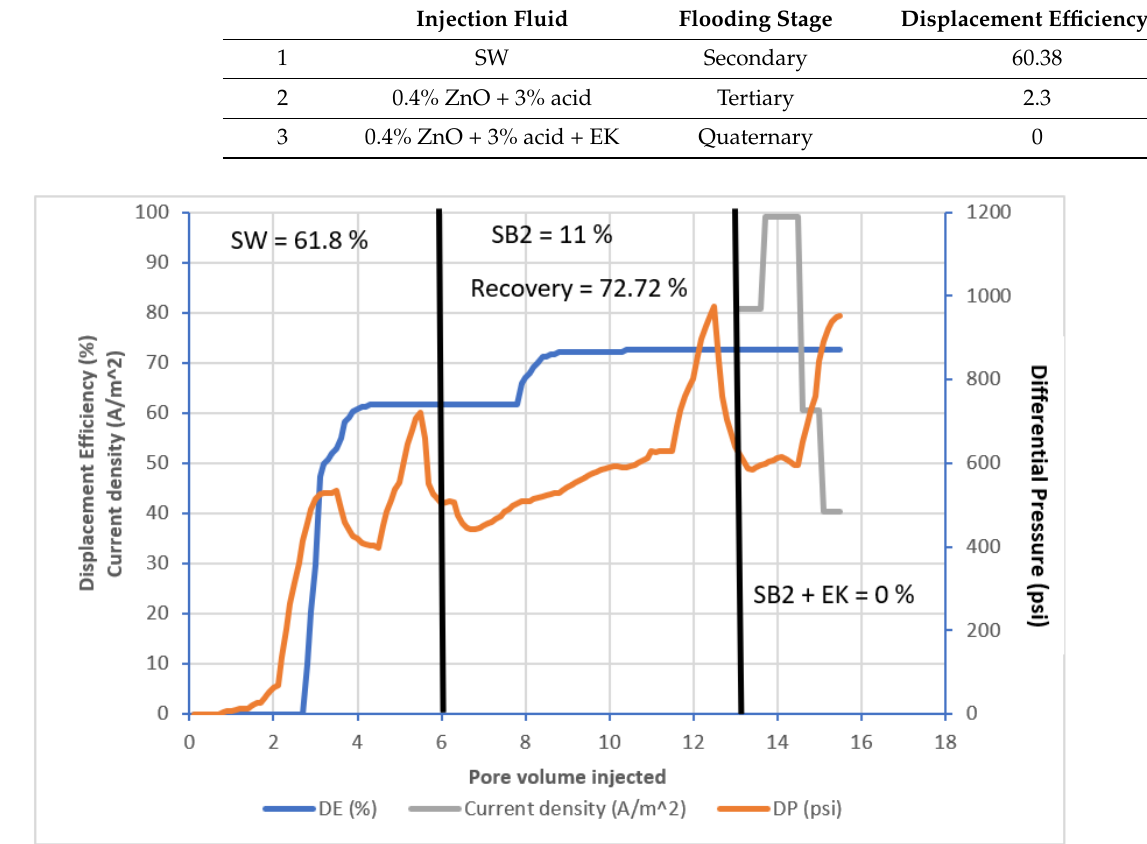
Figure 4. DE, DP (ΔP), Current Density vs. Pore Volume Injected for CF3 . Figure 4. DE, DP ( ∆ P), Current Density vs. Pore Volume Injected for CF3.